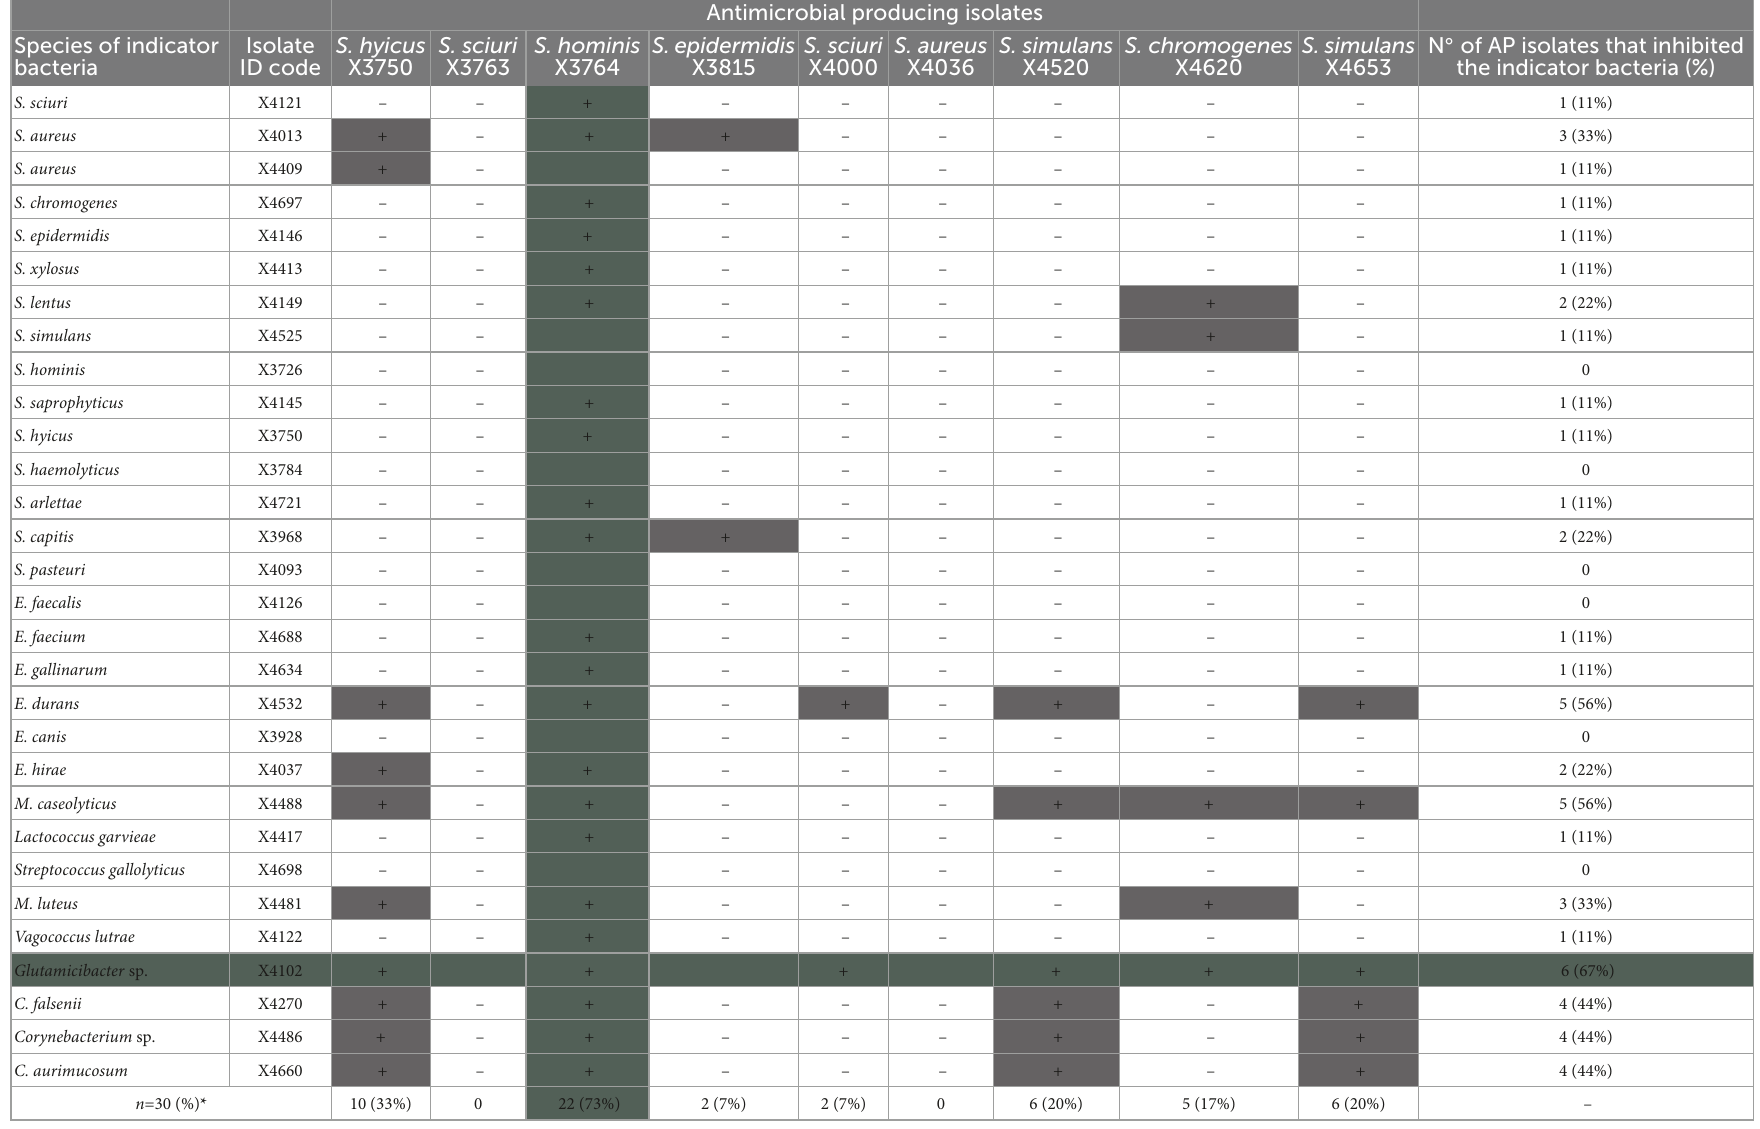
TABLE 3 Antimicrobial activity of the nine antimicrobial-producing (AP) isolates against a representative Gram-positive stork microbial community (30 isolates of 29 species used as indicator